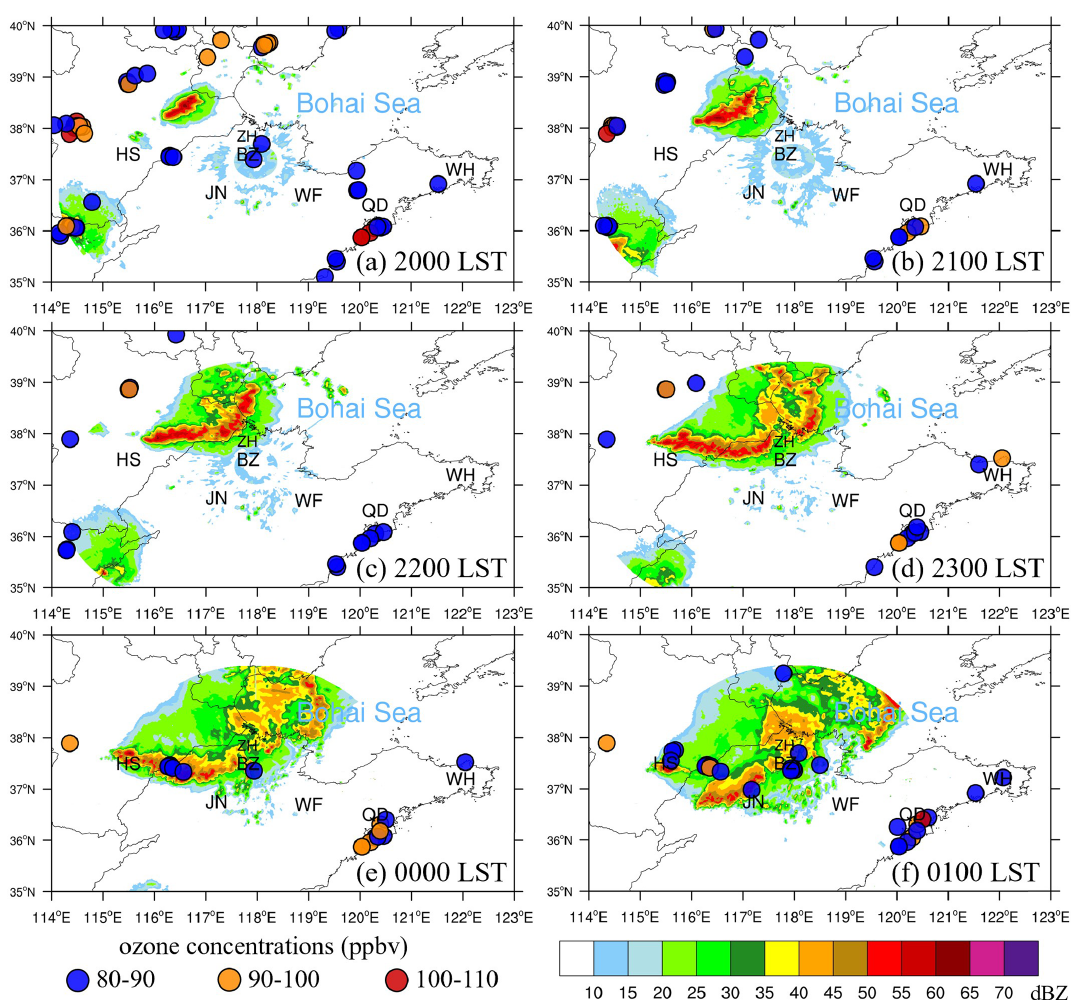
Figure 8. (a)–(f) Observed radar reflectivity structure (shaded; dBZ) of the bow-echo MCSs at night on 31 July 2021. Stations with high ozone concentrations are mapped by large circles in different colors. Stations with ozone concentrations less than 80ppbv are not displayed for